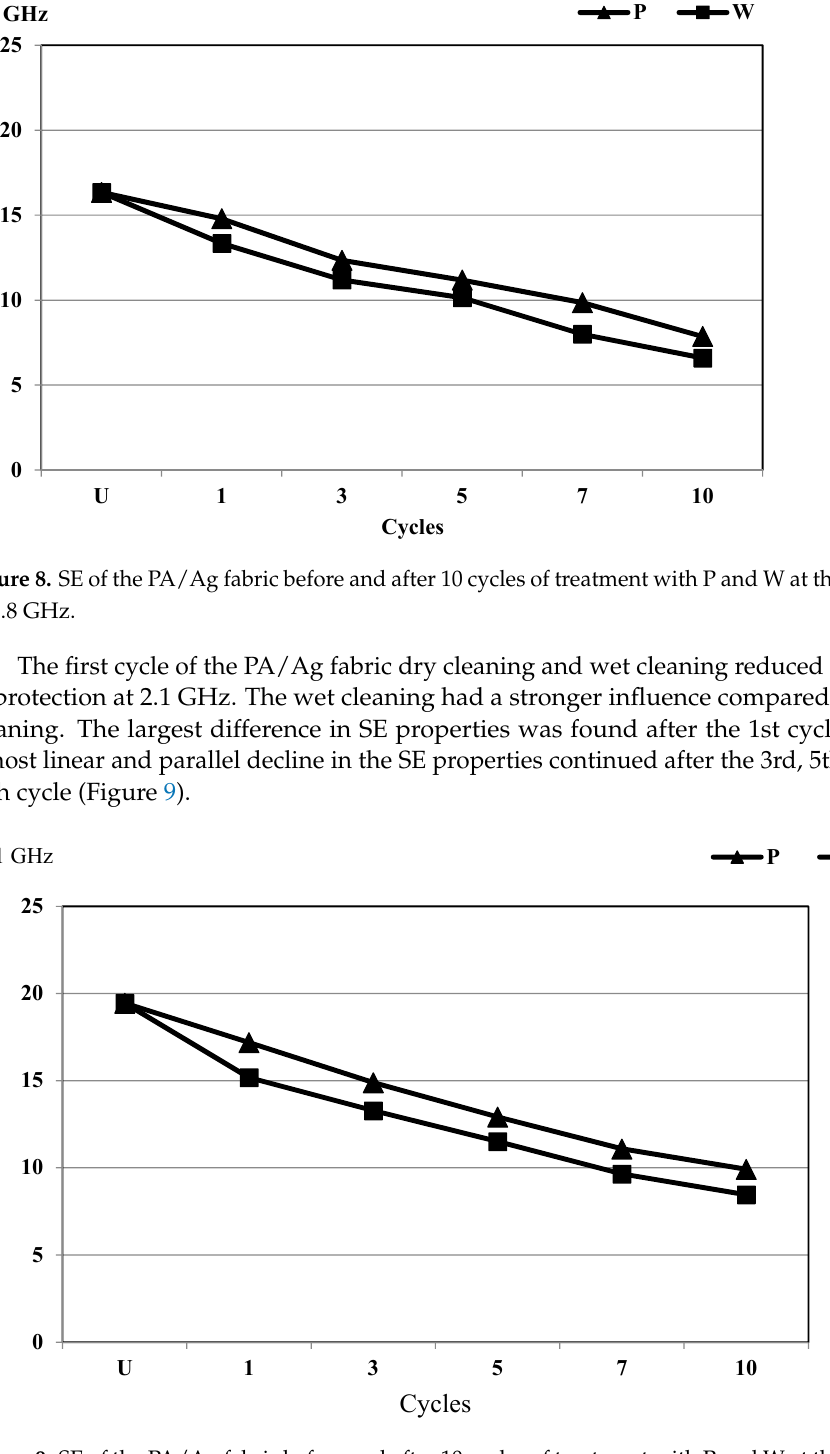
Figure 9. SE of the PA/Ag fabric before and after 10 cycles of treatment with P and W at the frequency of 2.1 GHz.